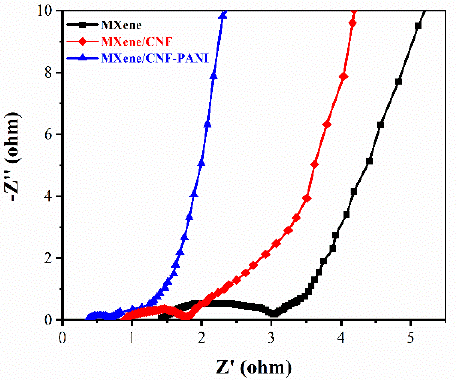
Figure 6. Nyquist curves of MXene films, MXene/CNF aerogel films and MXene/CNF–PANI aerogel films.